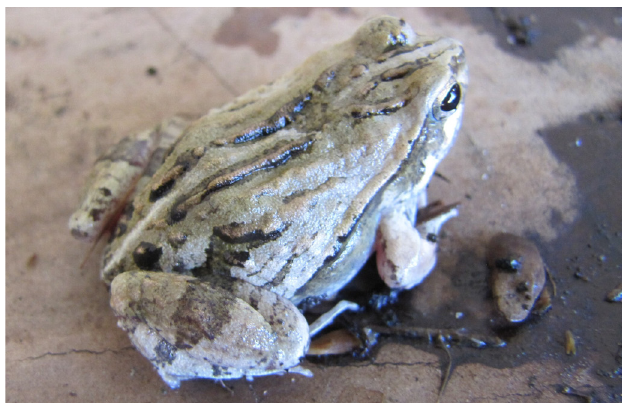
Figure 1. Physalaemus albifrons (MUFAL 8793), collected in the Cariri da Prensa farm, municipality of Boca da Mata, state of Alagoas, Brazil. Photo by Ubiratan Gonçalves.